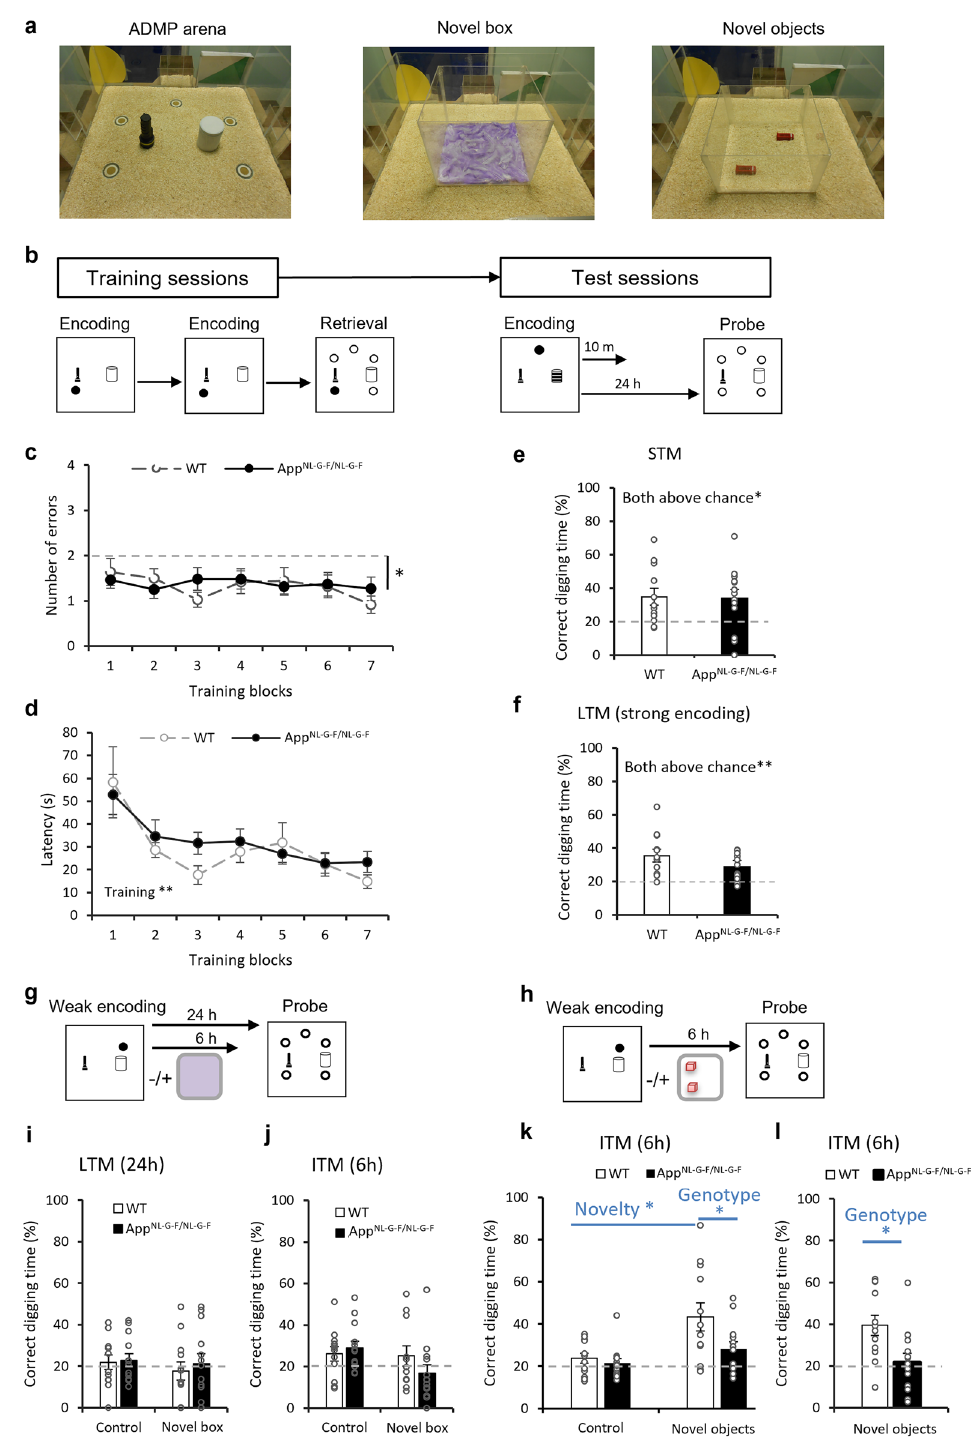
Figure 1. Appetitive spatial learning, memory, and novelty-promoted memory (via BTC) in adulthood. ( a ) The event arena (left), a box with novel substrates (middle), and a box with novel objects (right). ( b ) The ADMP training and testing procedures. ( c ) Comparable task acquisition in WT and App NL-G-F/NL-G-F mice across 7 training blocks. The errors were significantly below chance. ( d ) Comparable efficiency (latencies in the retrieval trials) in WT and App NL-G-F/NL-G-F mice